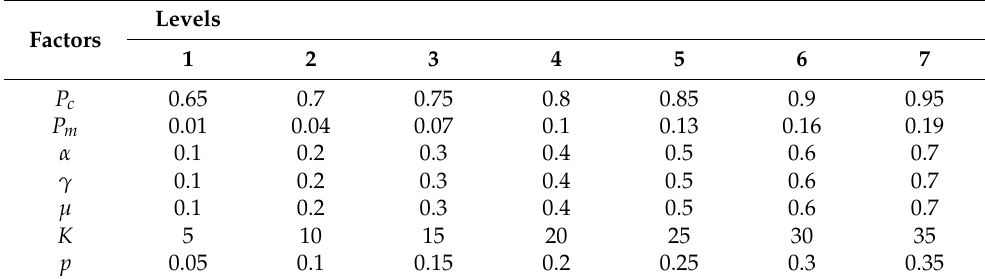
Table 5 indicates that each set of parameters enables the algorithm to optimize to the same optimal value. Table 2. Factors and levels for orthogonal experiment.